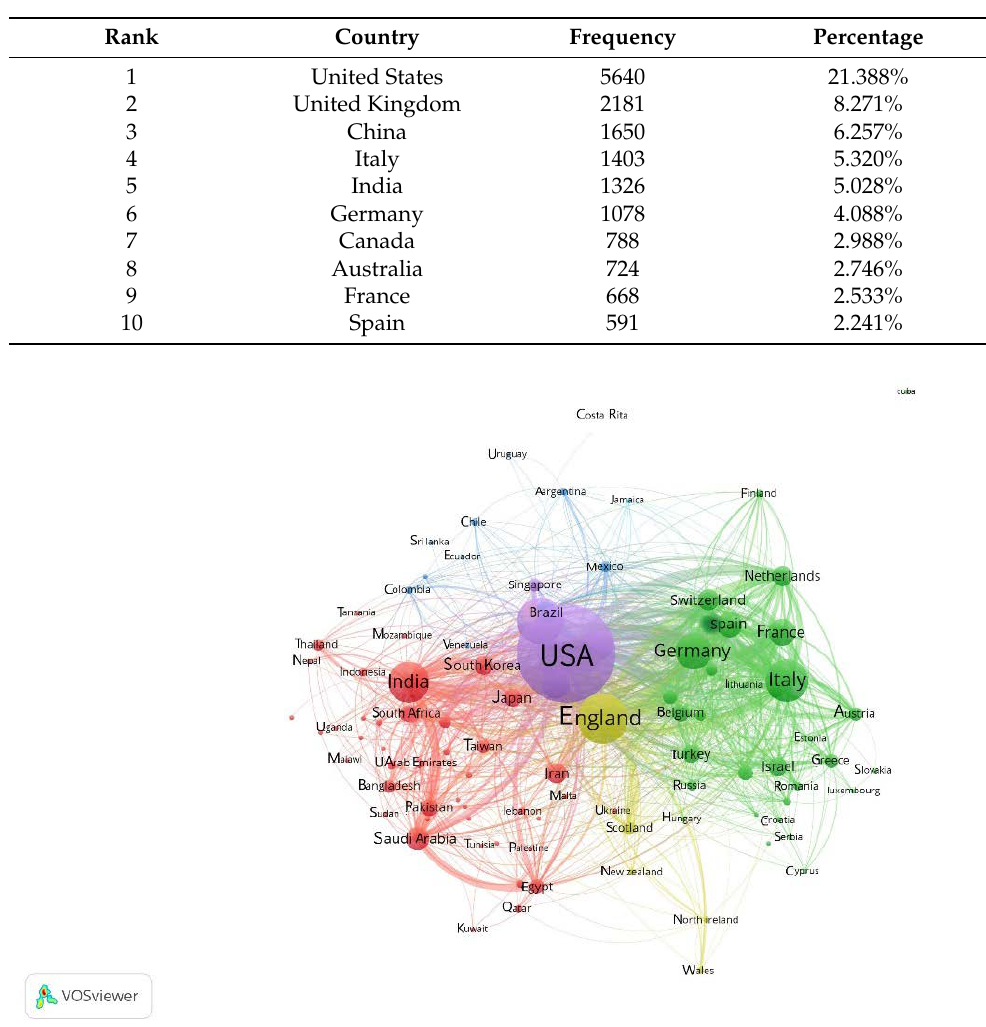
Table 3. The top 10 countries of journals with publications on COVID-19 vaccines.